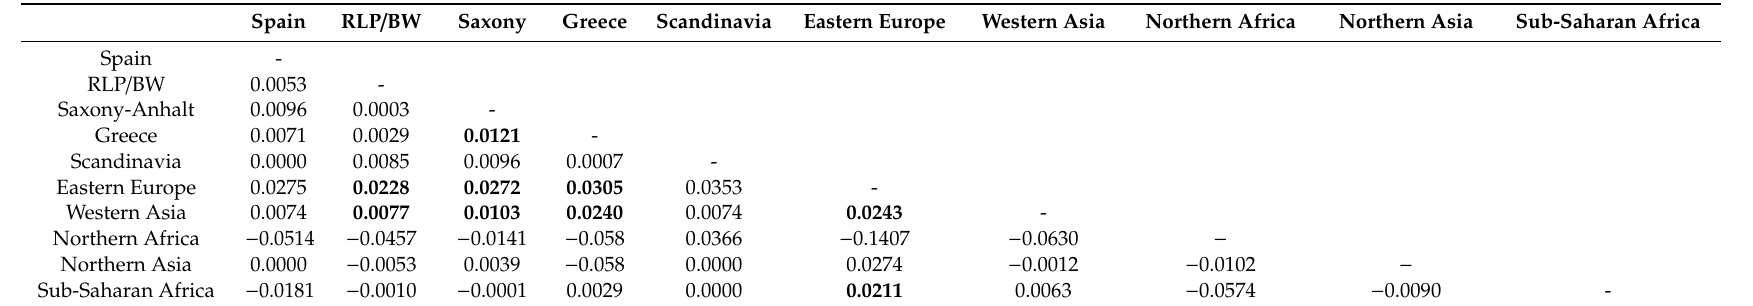
Table 6. Analysis of molecular variance (AMOVA) for six microsatellite loci to test the variation among the following breeding populations of the bee-eaters: Group 1 (Spain, Germany (RLP, BW, Saxony-Anhalt), Greece); Group 2 (Denmark, Sweden); Group 3 (Slovakia); Group 4 (Turkey, Georgia, Kuwait); Group 5 (Egypt, Tunisia); Group 6 (Kazakhstan, Russia) and Group 7 (Southern Africa, Malawi). Source of Variation Sum of Squares Percentage of Variation F ST p Value